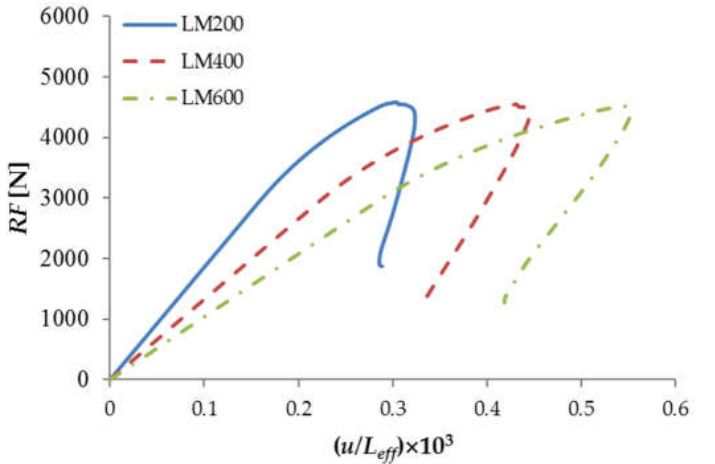
Figure 10. Normalized load-deflection diagrams from deterministic FEM simulations with various beam spans.